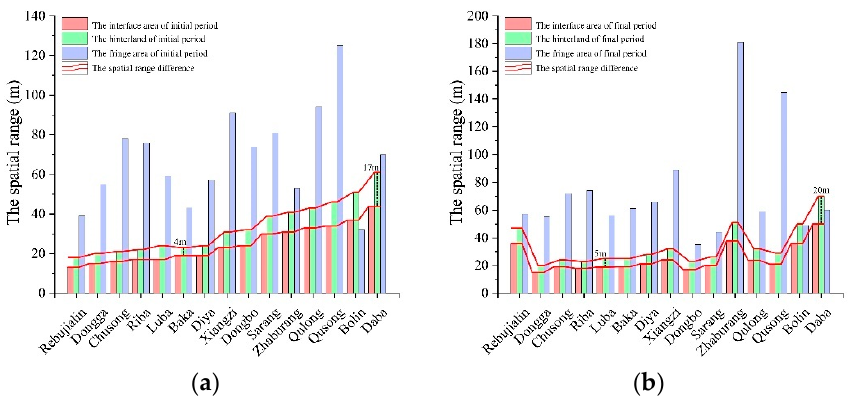
Figure 8. Spatial division range of rural settlement in initial year and final year. ( a ) Initial year. ( b ) Final year.